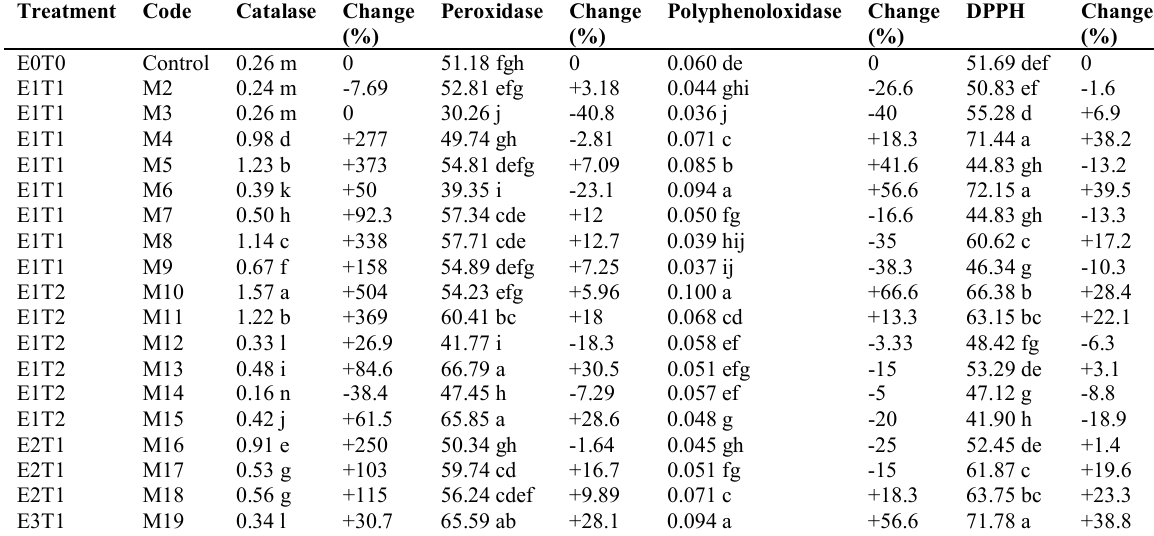
Table 2 . Mean comparison of some antioxidant enzymes in samples treated by EMS Treatment